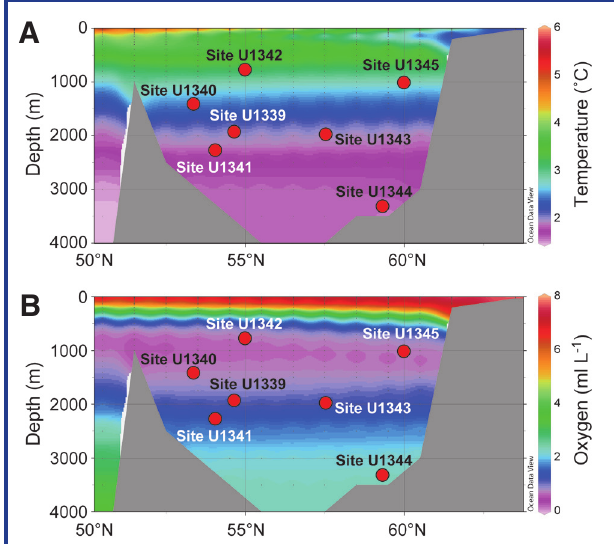
Figure 2. Vertical profiles of [A] temperature and [B] dissolved oxygen along the transect on 180° meridian line in the Bering Sea (data from World Ocean Atlas (2005); figures drawn by Ocean Data